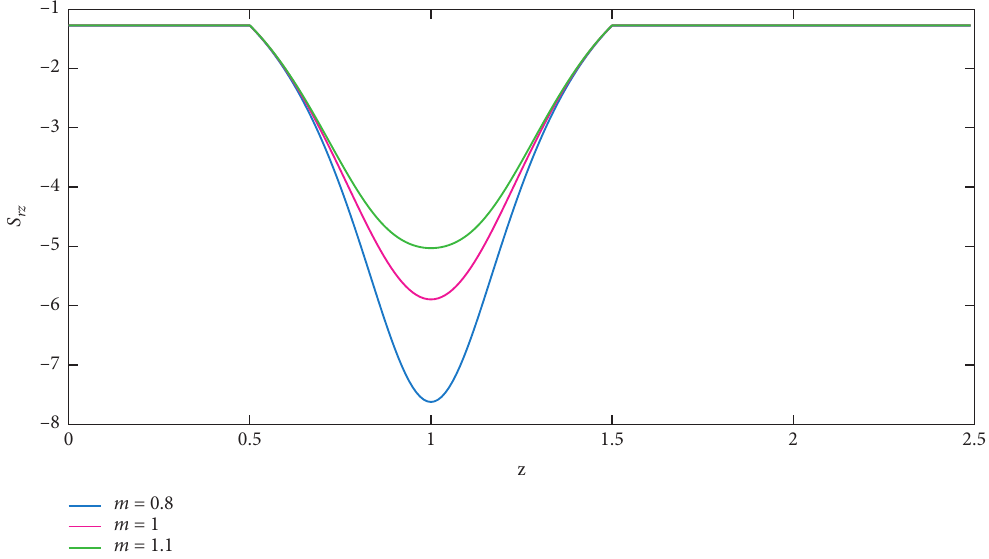
Figure 5: Wall shear stress variation for the Carreau model for n � 2 , L � 1 , F � 1 , and We � 0 . 2.